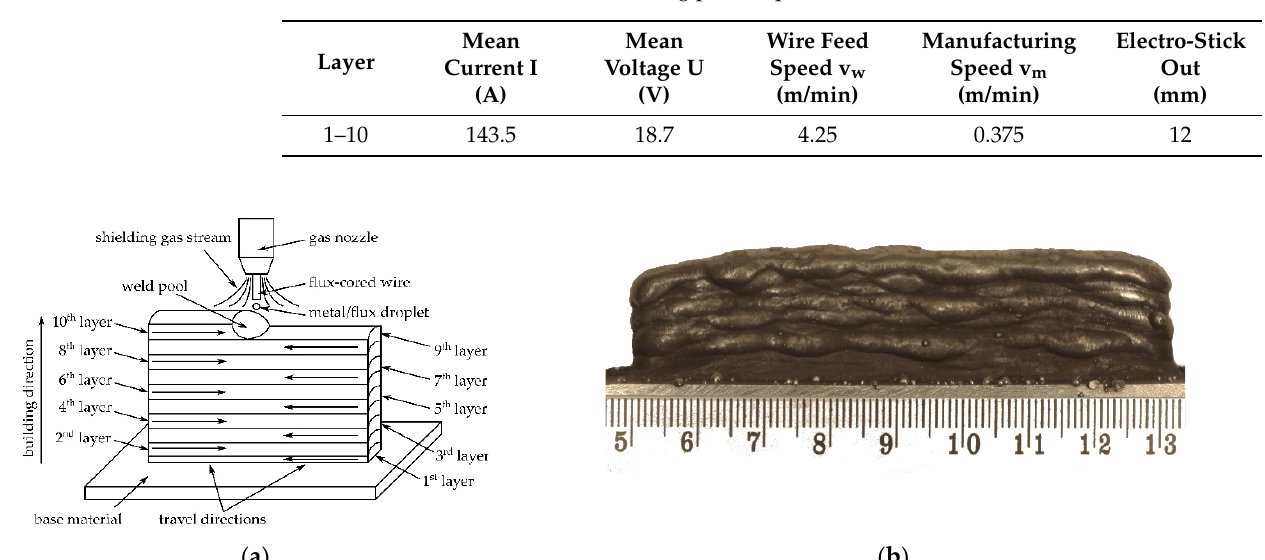
Figure 1. Wire arc additive manufactured 18Ni-12Co-4Mo-Ti maraging steel part: ( a ) manufacturing strategy, ( b ) general view.